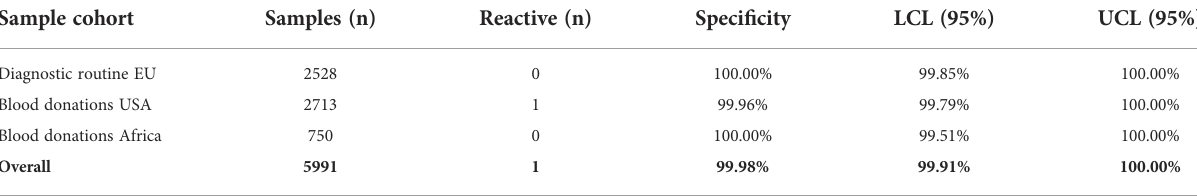
TABLE 1 Speci fi city in samples obtained from routine diagnostic laboratories and blood donors